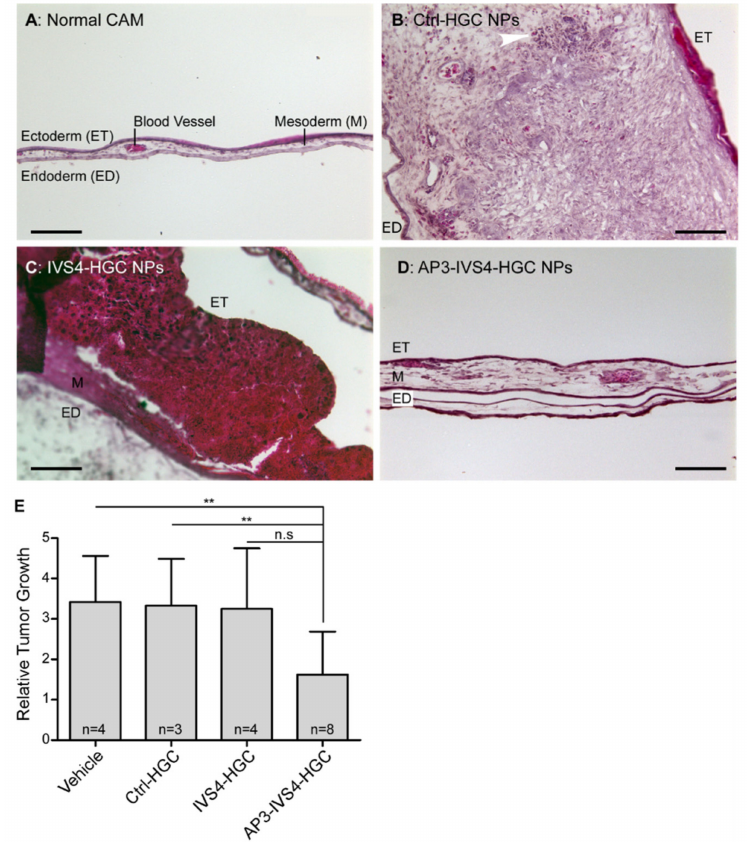
Figure 6. Encapsulation of AP3 by IVS4-Cy3-HGC kills MMP-14-expressing cancer cells and